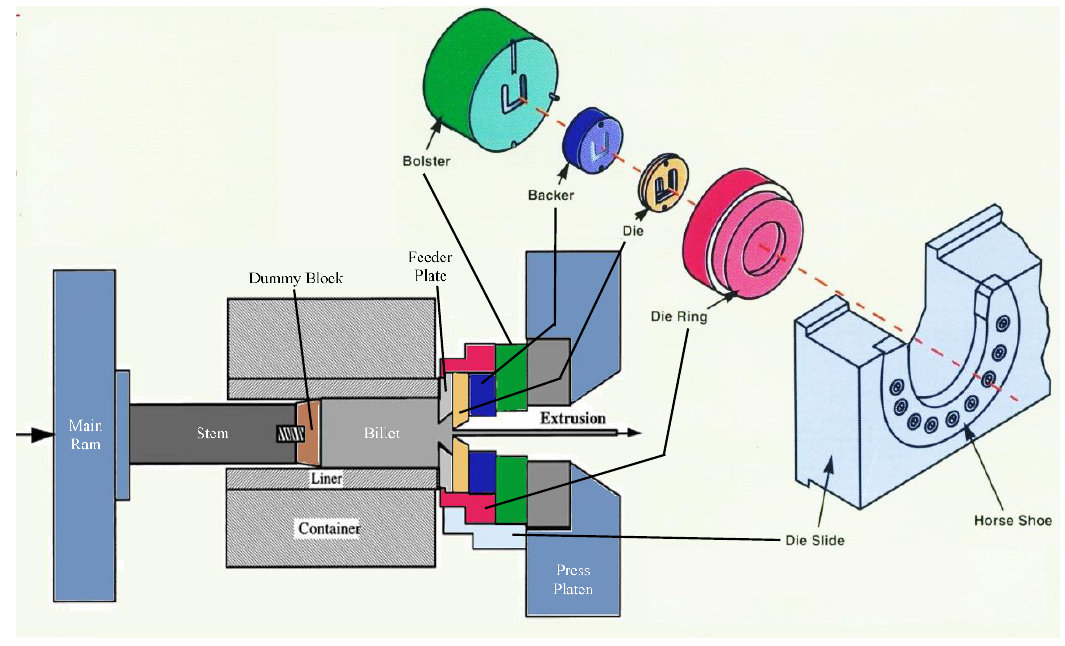
Figure 2. Schematic layout of the extrusion press and tooling.